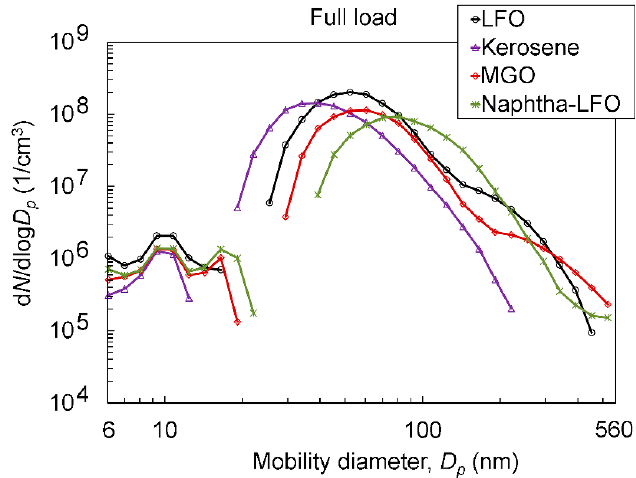
Figure 2. Exhaust particle size distributions (PSD) at full load.